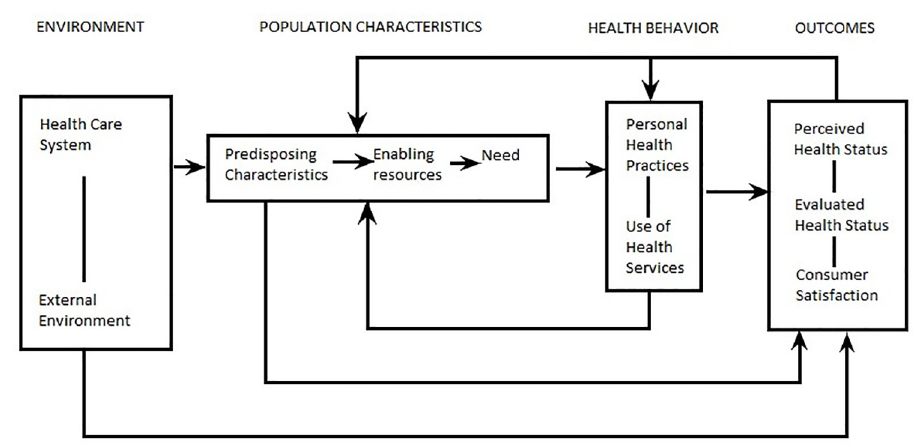
Fig 1. Andersen’s Behavioural Model of health service use